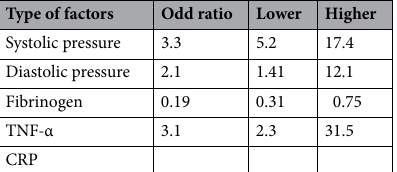
Table 2. Odds ratios for increasing of cardiovascular biomarkers and blood